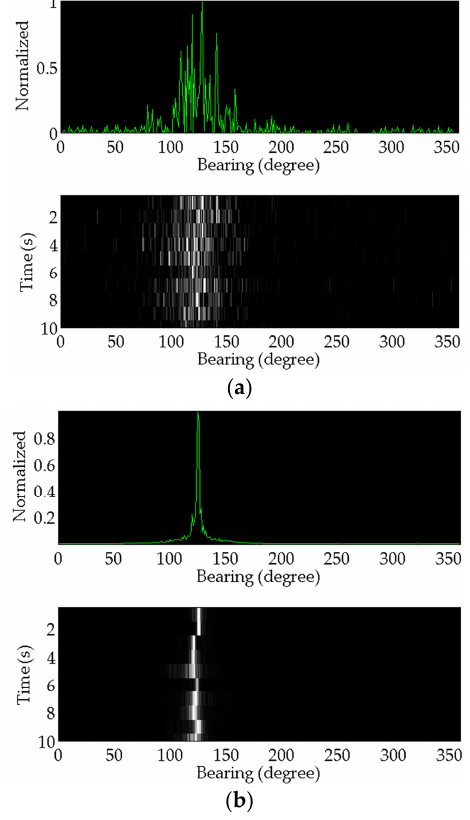
Figure 6. The processing results: ( a ) The result of the conventional method; ( b ) The result of the proposed method.